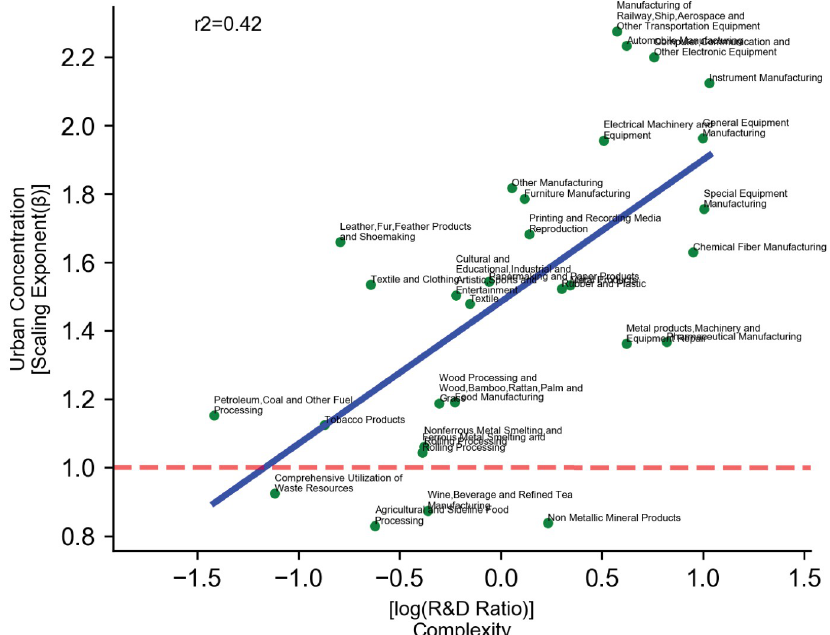
Fig 4. Urban concentration & complexity. The x-axis denotes the complexity of a sector. Complexity is measured here as the natural logarithm of the ratio between R&D expenditure and revenue. A higher value indicates greater knowledge complexity. The y-axis denotes urban concentration (measured by the scaling exponent of employment). Urban concentration increases for more complex manufacturing industries. The red dashed line separates super-linear scaling from sub-linear scaling.